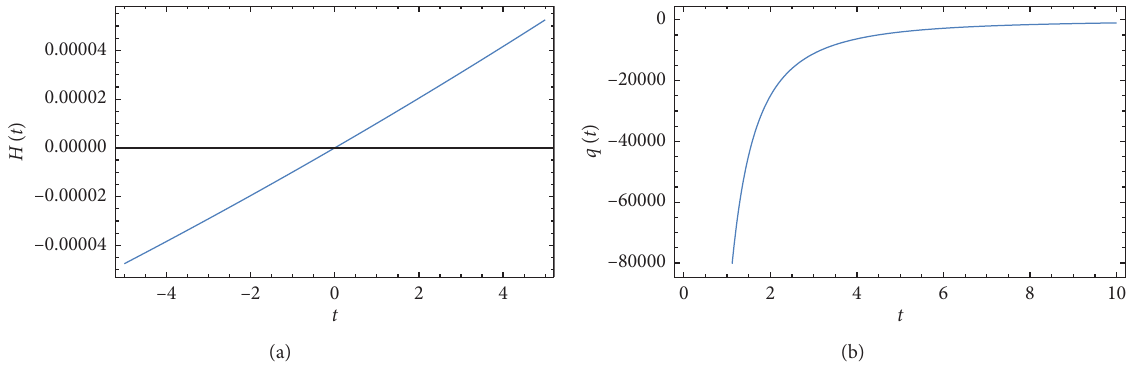
Figure 4: Evolution of the scale factor and red shift function for ω ζ � 0 . 01 ; ξ � 0 . 01 ; k � − 0 . 001 ; β � 0 . 005 ; λ � 0 . 005.